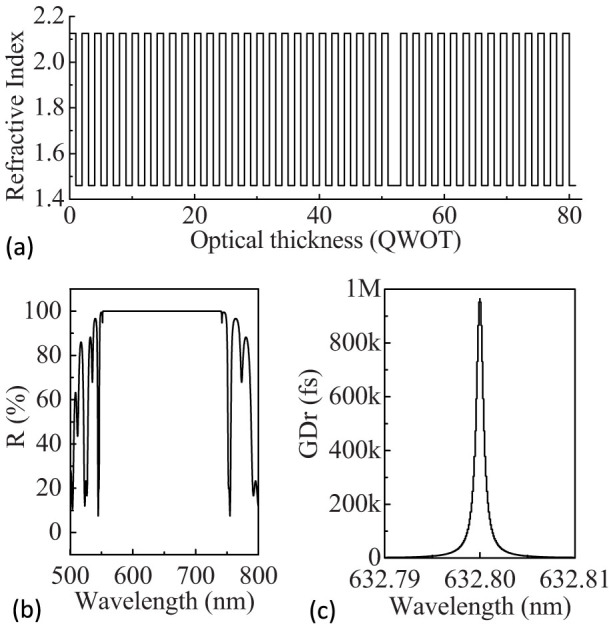
(a) Theoretical refractive-index profile of a high-reflectivity Ta2O5-SiO2 multilayer coatings (G/(HL)25H2L(HL)14/A) with huge group delay for M4. (b), (c) Computed reflectivity and group delay as a function of wavelength for the multilayer design of (a).